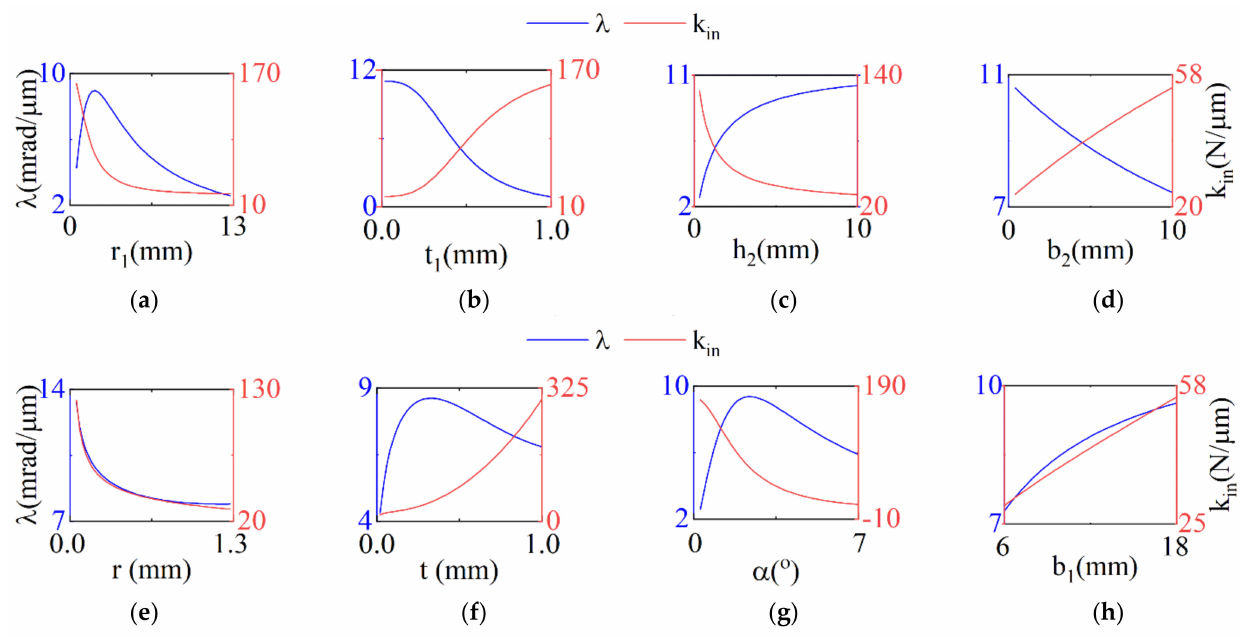
Figure 6. Effect of major dimensional parameter on input stiffness and transmission ratio. ( a ) Rotation radius. ( b ) Thickness of the leaf hinge. ( c ) Leaf hinge height. ( d ) Leaf hinge width. ( e ) Minimum thickness of right-circle hinge. ( f ) Radius of right-circle hinge. ( g ) Angle of connecting rod. ( h ) Width of the